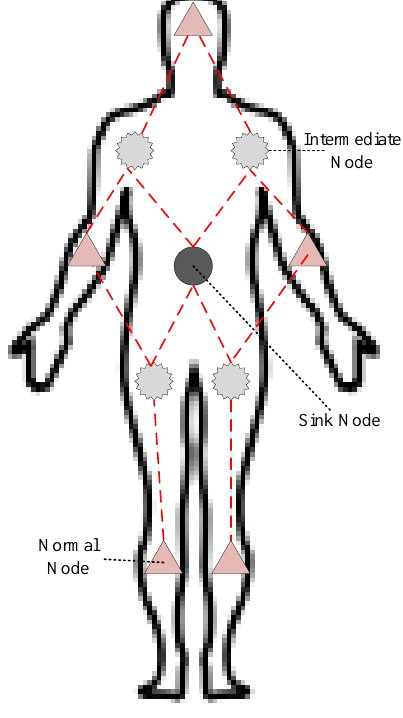
Figure 1. Deployments of nodes and their